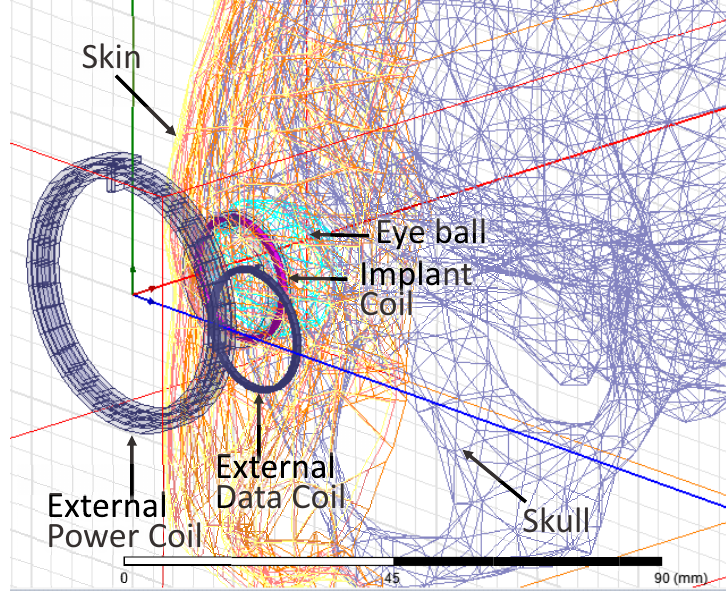
Figure 16. The magnetically-balanced inductive link is simulated with the human head model in ANSYS HFSS electromagnetic simulation